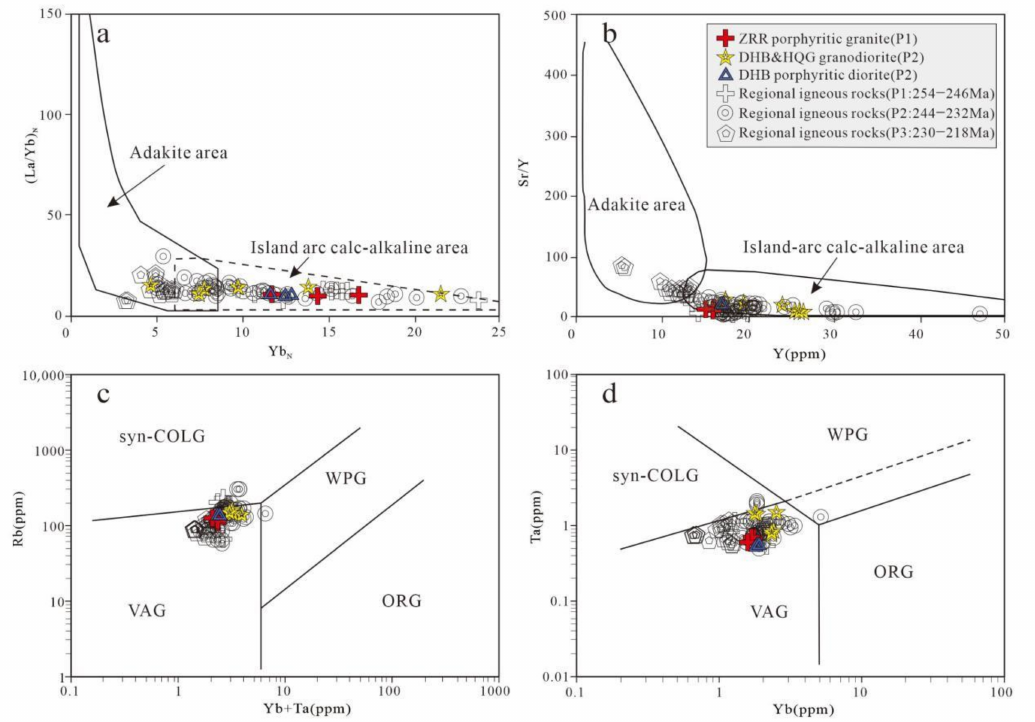
Figure 12. The discrimination diagram of the tectonic environment for early to late Triassic ranitoids in the eastern EKOB. ( a ) (La/Yb) N versus Yb N classification diagram [68]; ( b ) Sr/Y versus Y classification diagram [65]; ( c ) Rb versus Yb + Ta diagrams; ( d ) Ta versus Yb diagrams [32]. Abbreviations: syn-COLG = syn-collision granites; VAG = volcanic arc granites; WPG = within plate granites; ORG = ocean ridge granites. Data sources: The data for Regional igneous rocks (P1: 254–246 Ma) were from [1,4]; the data for Regional igneous rocks (P2: 244–232 Ma) were from [1–5,69]; the data for Regional igneous rocks (P3: 230–218Ma) were from